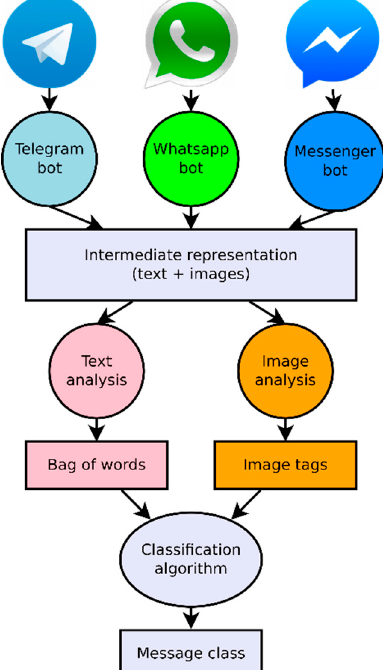
Figure 5. The data flow describing the citizen reports management.